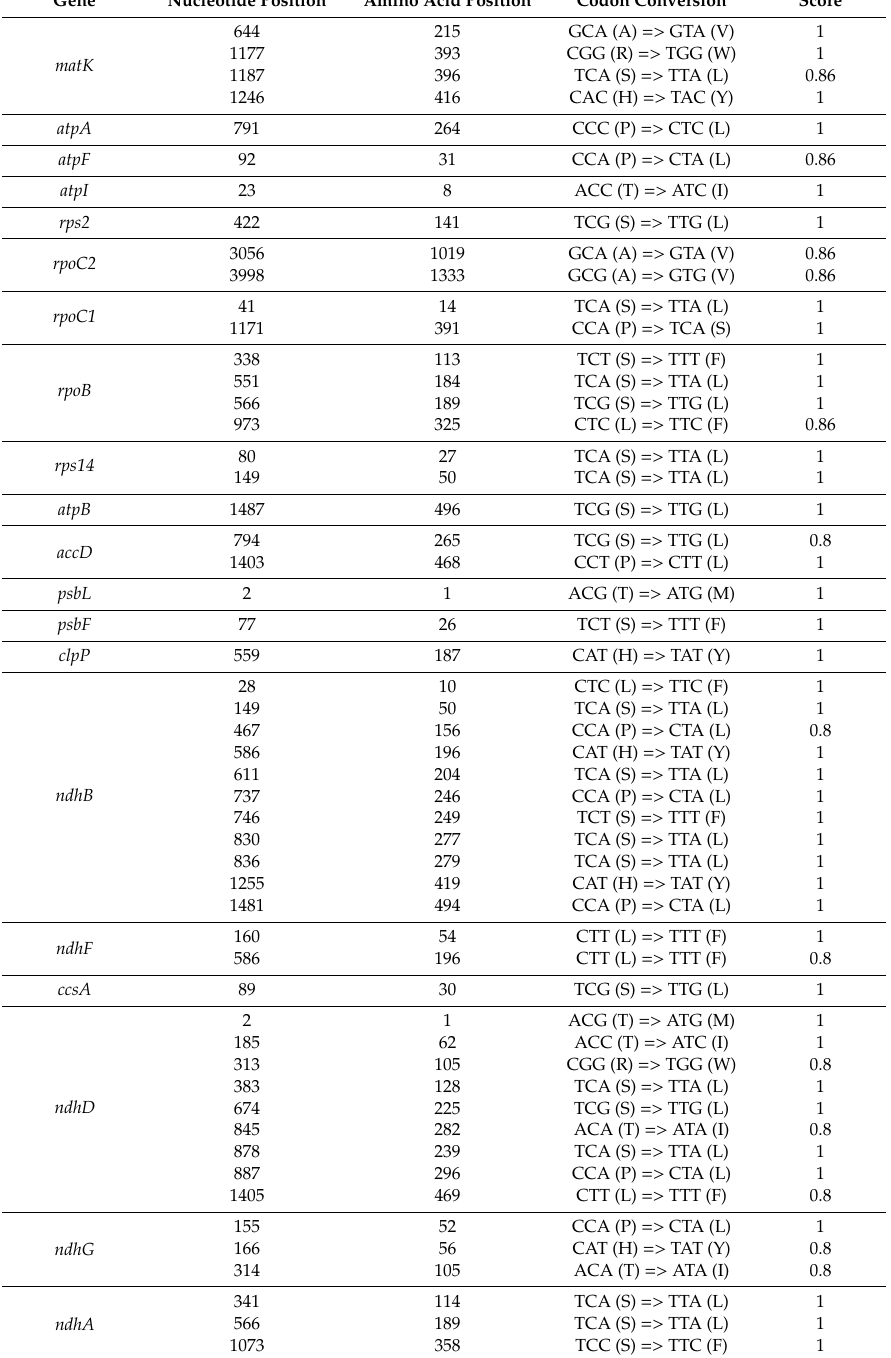
Table 3. Predicted RNA editing sites in the cp genome of P.